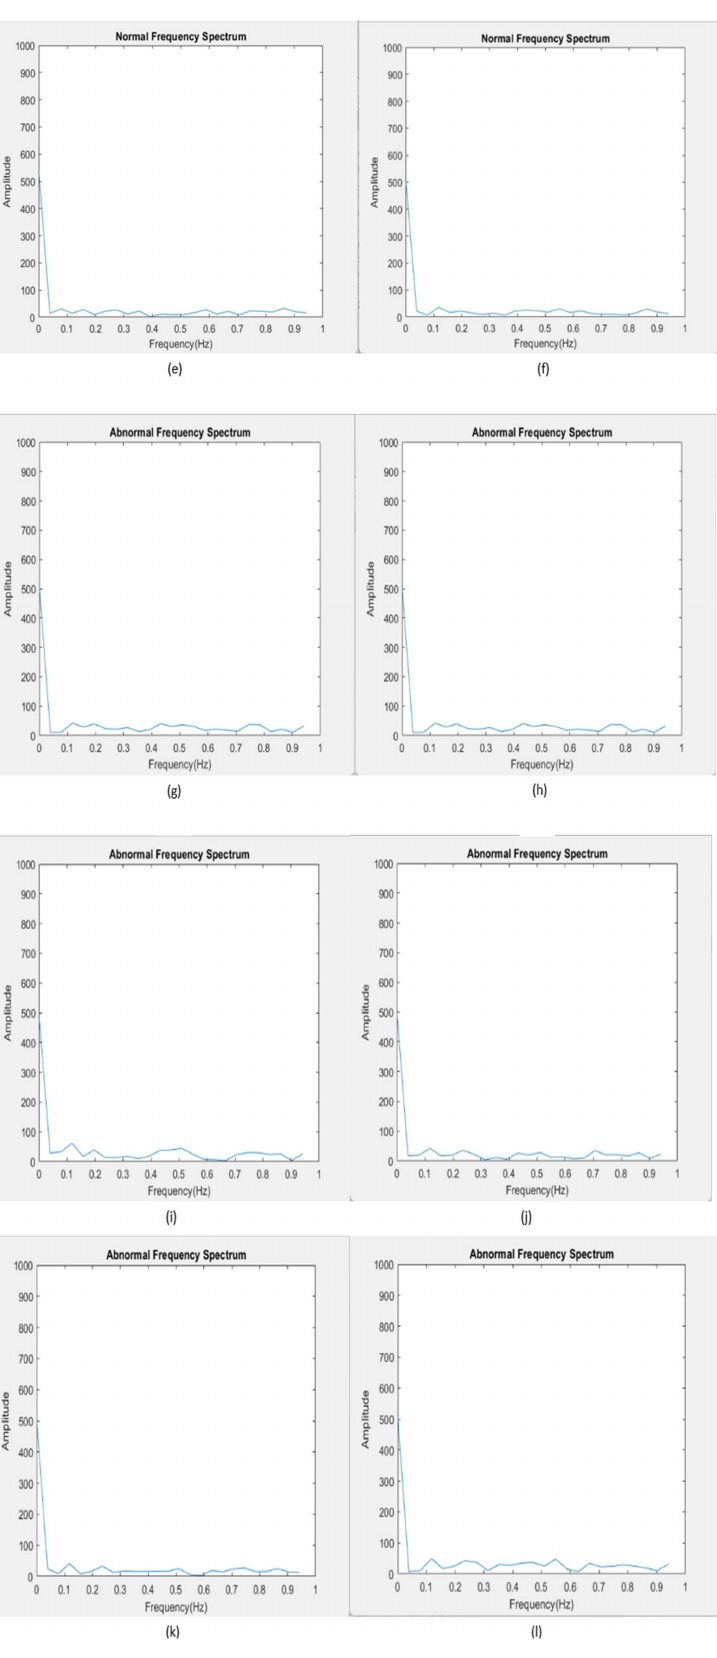
Figure 14. Segmented FFT spectrums for both normal and abnormal data sets: ( a – f ) segmented normal FFT spectrums, ( g – l ) segmented abnormal FFT